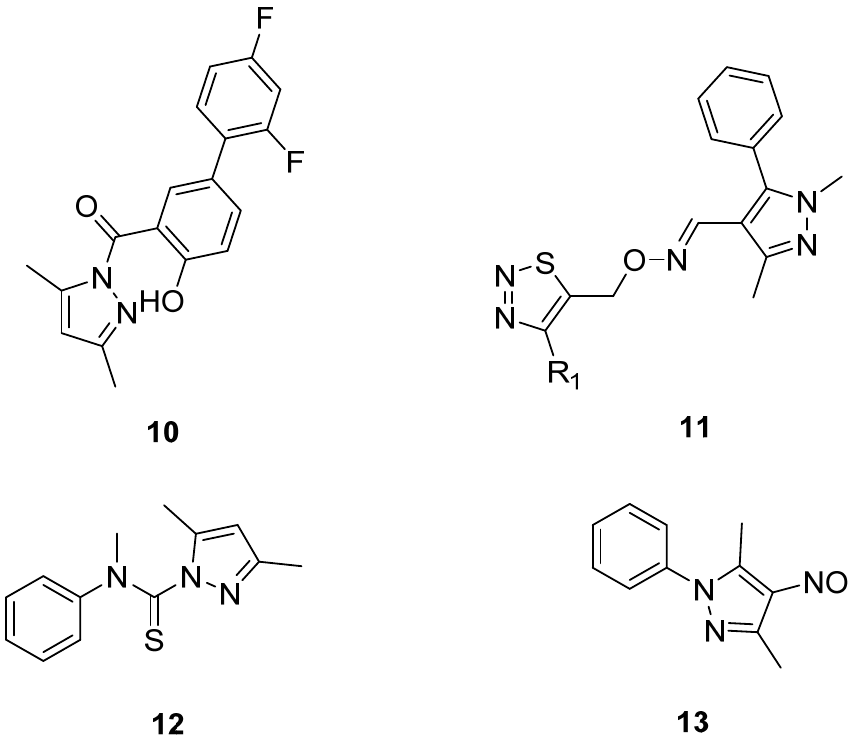
Figure 3. Chemical structures of cytotoxic compounds with a dimethylpyrazole ring. (2',4'-difluoro- 4-hydroxy-[1,1'-biphenyl]-3-yl)(3,5-dimethyl-1H-pyrazol-1-yl)methanone ( 10 ), (E)-1,3-dimethyl-5- phenyl-1H-pyrazole-4-carbaldehyde O-((1,2,3-thiadiazol-5-yl)methyl) oxime derivatives ( 11 ), N,3,5- trimethyl-N-phenyl-1H-pyrazole-1-carbothioamide ( 12 ), 3,5-dimethyl-4-nitroso-1-phenyl-1H-pyra- zole ( 13 ).